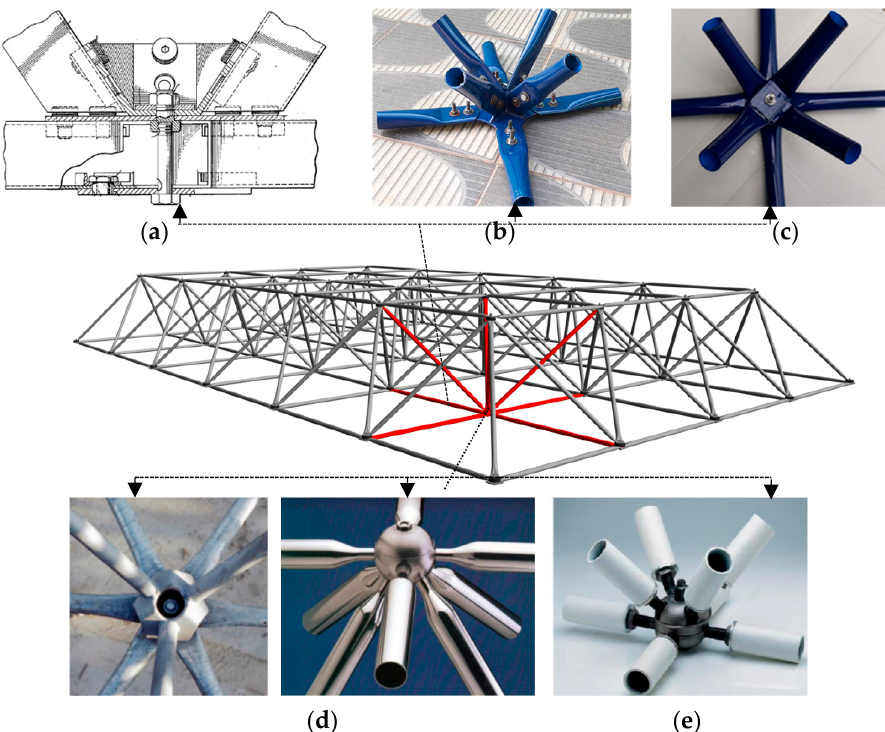
Figure 2. Typical connection models for space trusses. ( a ) Typical connection used in the United States in 1960. ( b ) Connection with flattened steel tube at the ends and bolts in thin-walled plate used in 1968. ( c ) Typical connection with flattened steel tube at the ends and connected with a bolt used in 1968. ( d ) Connections proposed by Du Château in 1970. ( e ) VESTRUT system patented connection space in 1980.